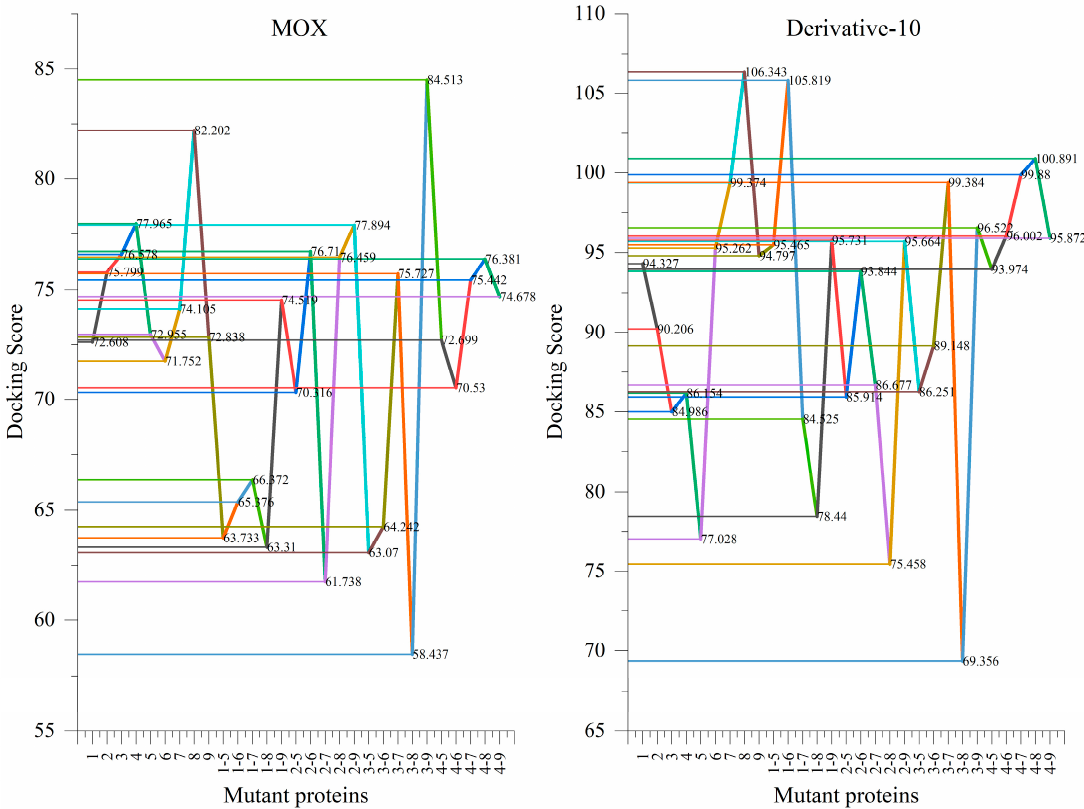
Figure 5. Docking results for MOX and Derivative-10 with all mutant proteins of Escherichia coli DNA gyrase.